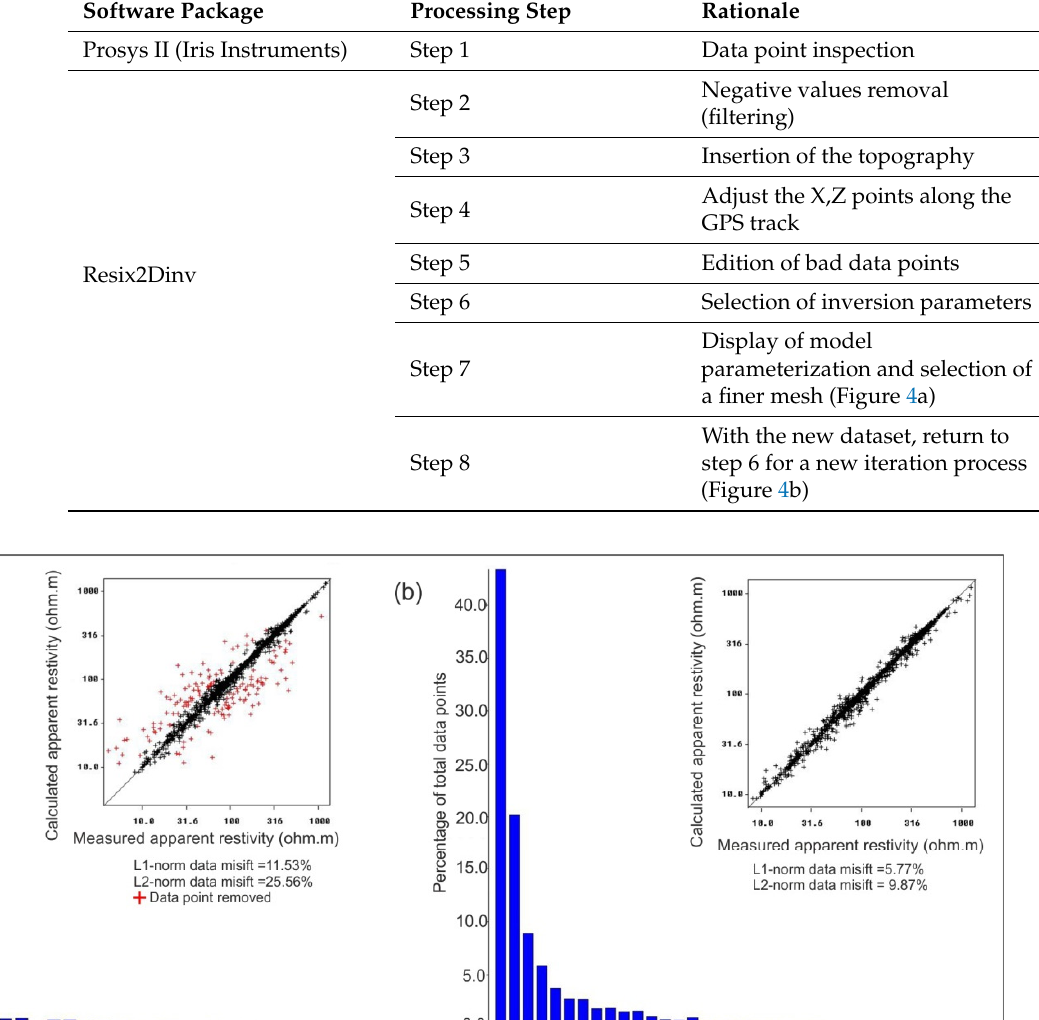
Table 2. Description of the seismic parameters in the study area.